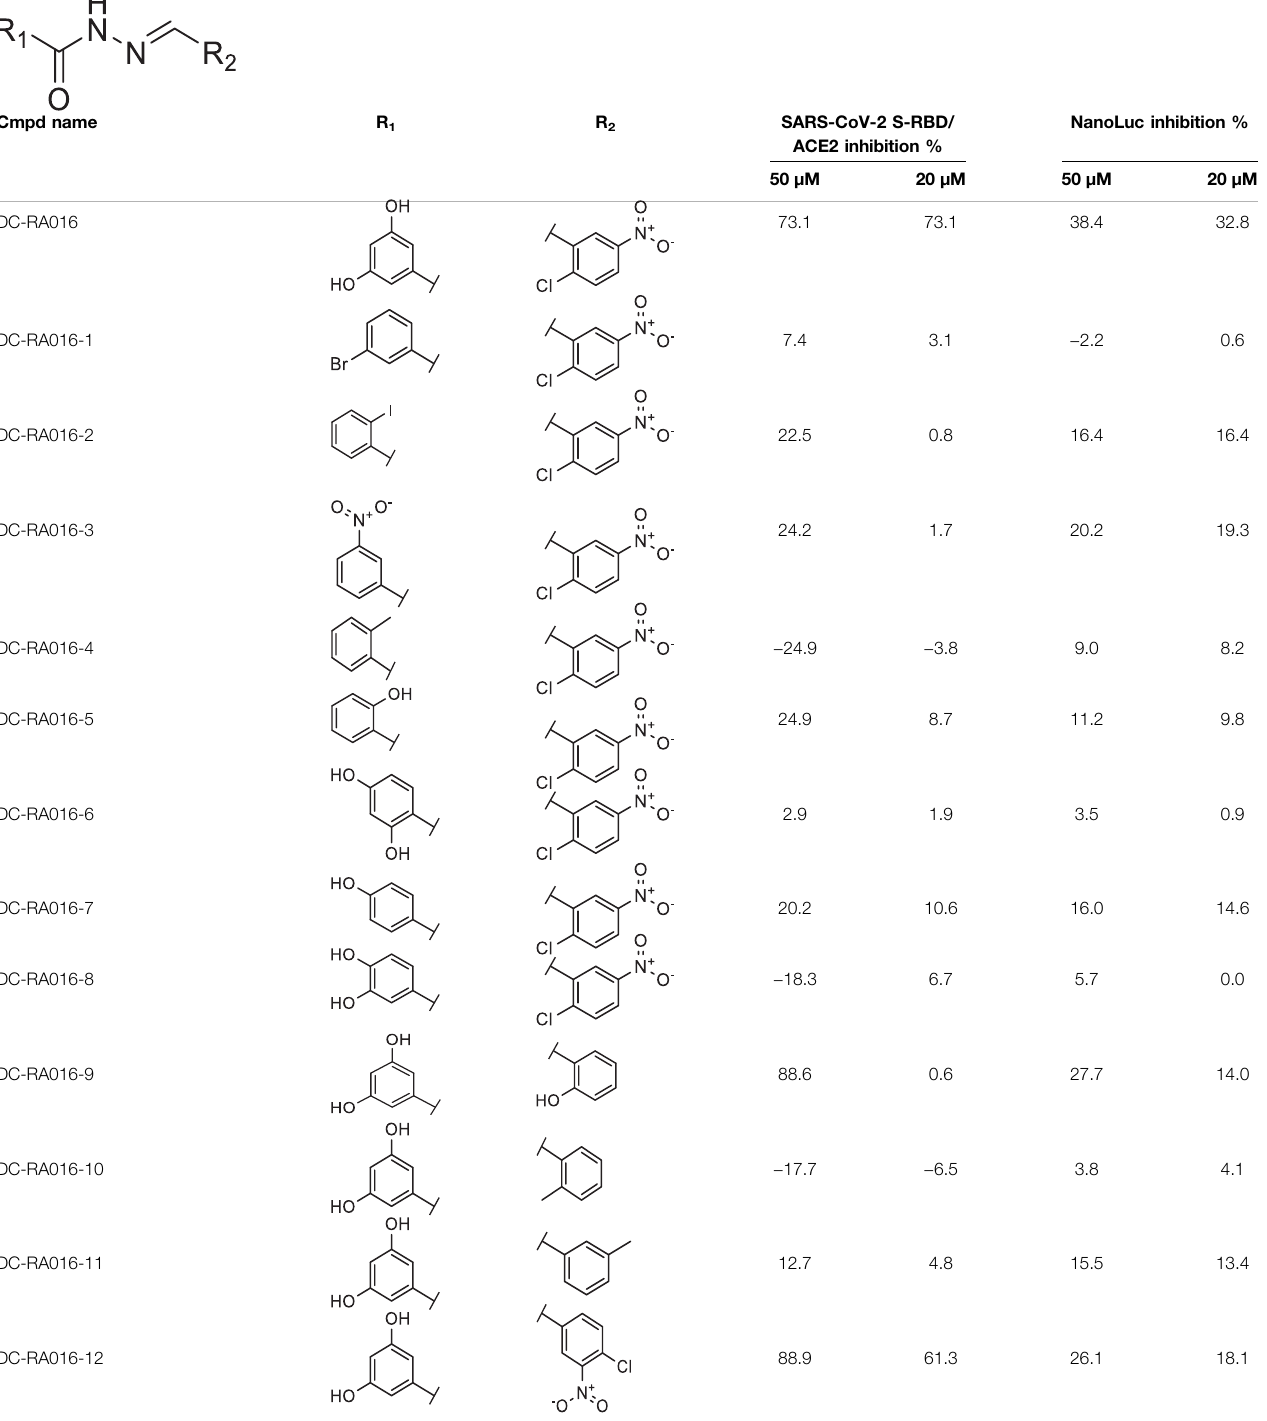
TABLE 2 | The activities of DC-RA016 analogues in NanoBiT-based